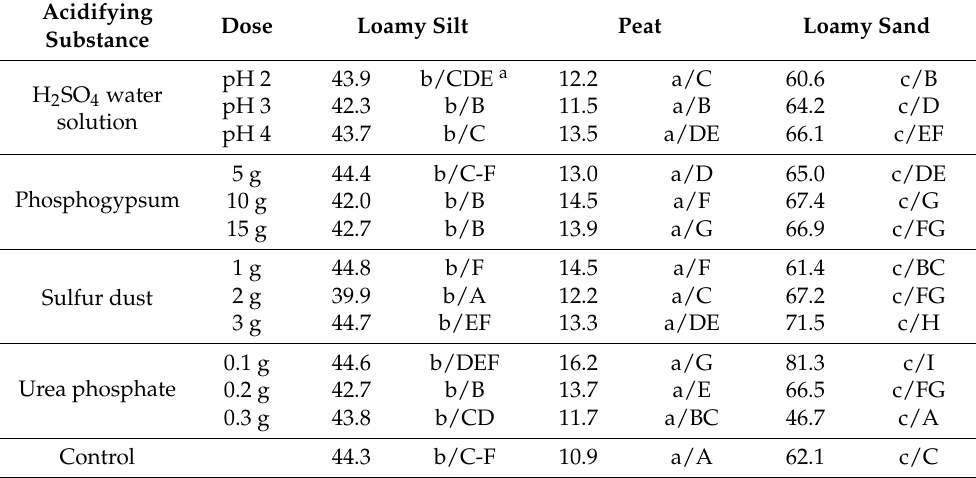
Table 10. Effects of acidifying substances after 12 months on the content of available zinc in loamy silt, peat and loamy sand